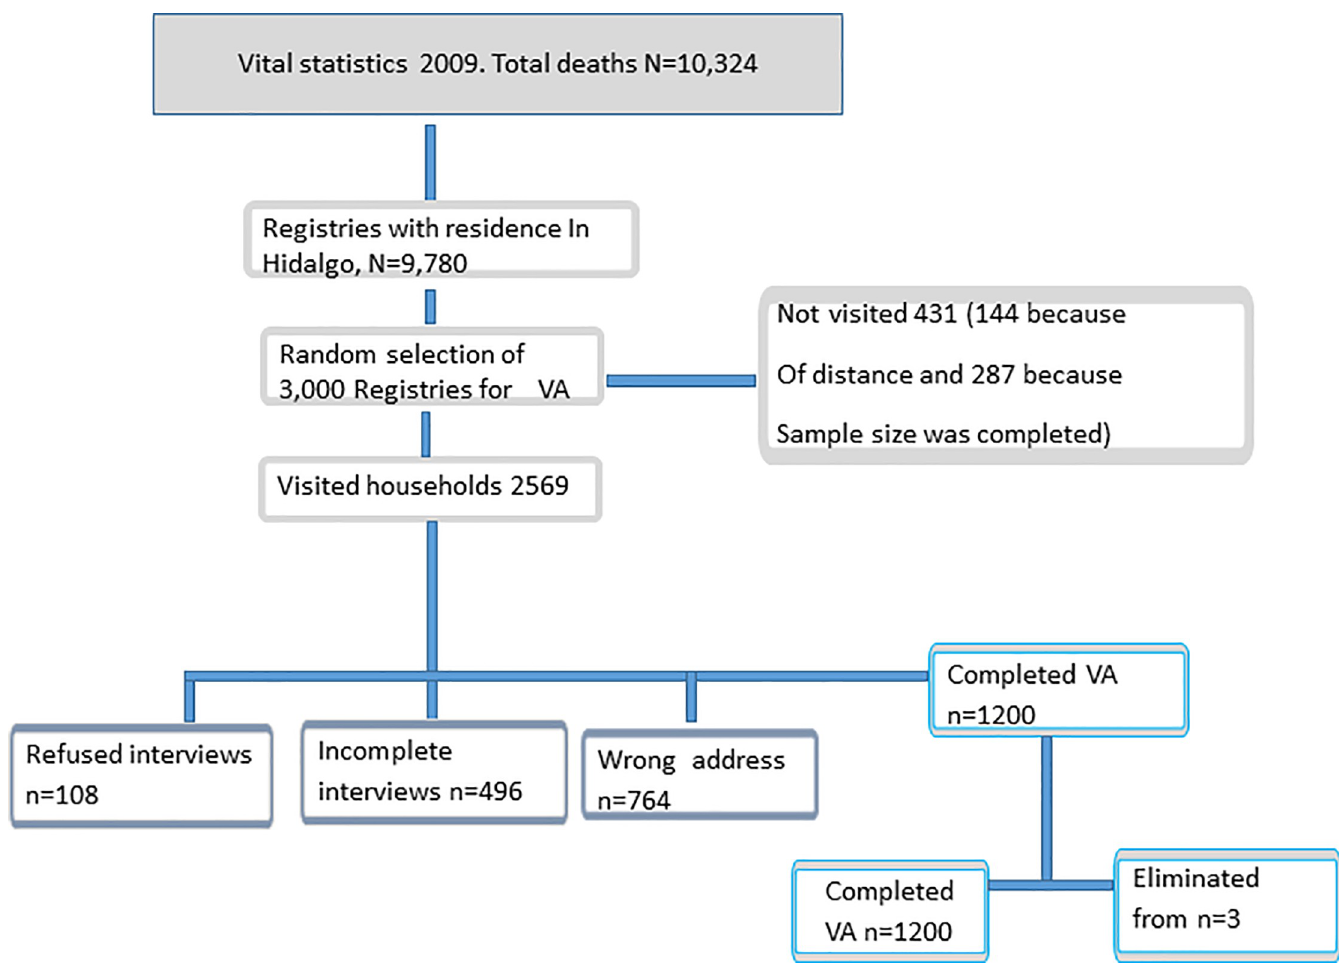
Fig 1. Verbal autopsy sample selection, Mexico, Hidalgo